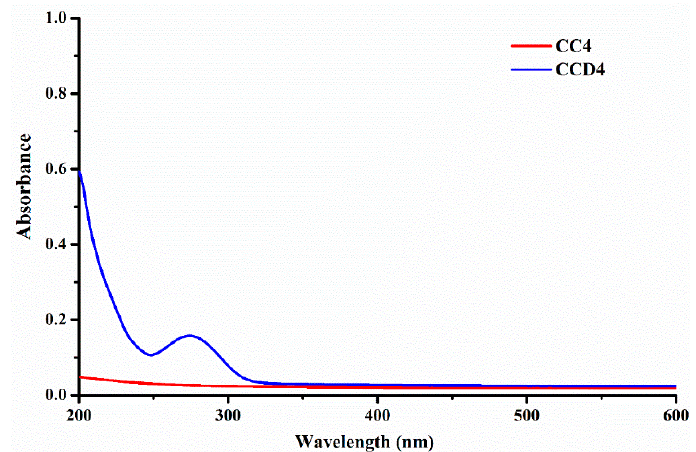
Polymers 2020 , 12 , x FOR PEER REVIEW 13 of 17